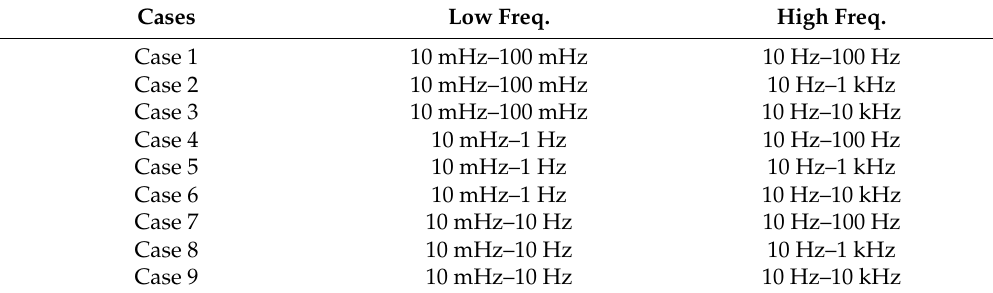
Table 5. Proposed combinations. Low Freq. High